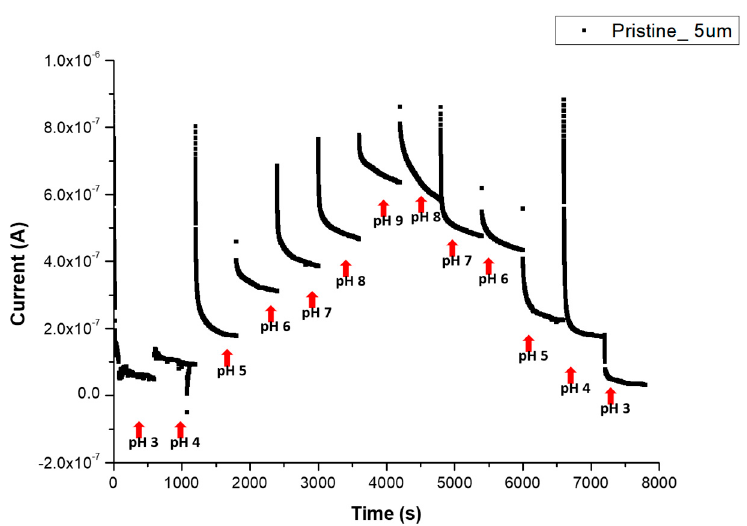
Figure 7. Real-time pH response measurement of p-CNTFET from pH 3 to pH 9 (upward direction) and from pH 9 to pH 3 (downward direction) in PBS. V ds is set to +0.8 V and V gs is set to − 0.8 V.